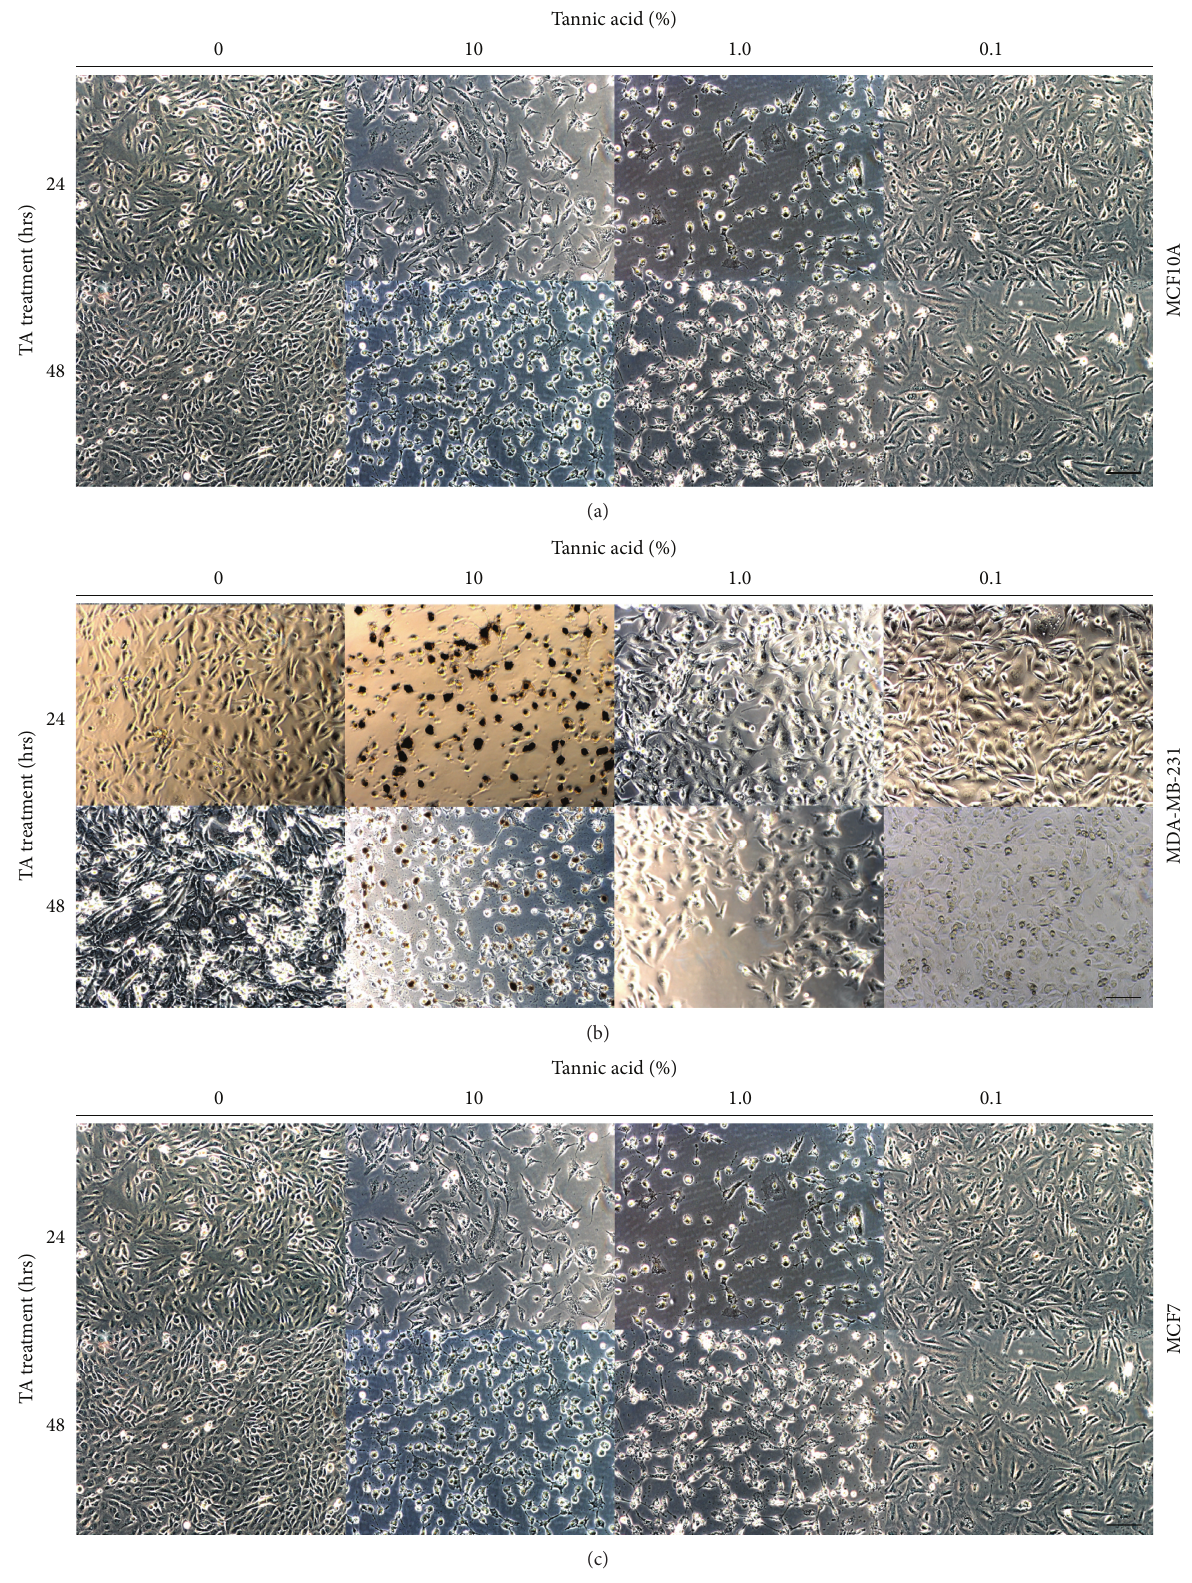
Figure 2: Treatment of human breast cells with tannic acid. Light microscopic images of three human breast cell lines (a) MCF10A, (b) MDA- MB-231, and (c) MCF7; cells were grown to near confluence prior to treatment with 10%, 1.0%, and 0.1% TA cross-linked beads for 24–48 h. Scale bars = 50 𝜇